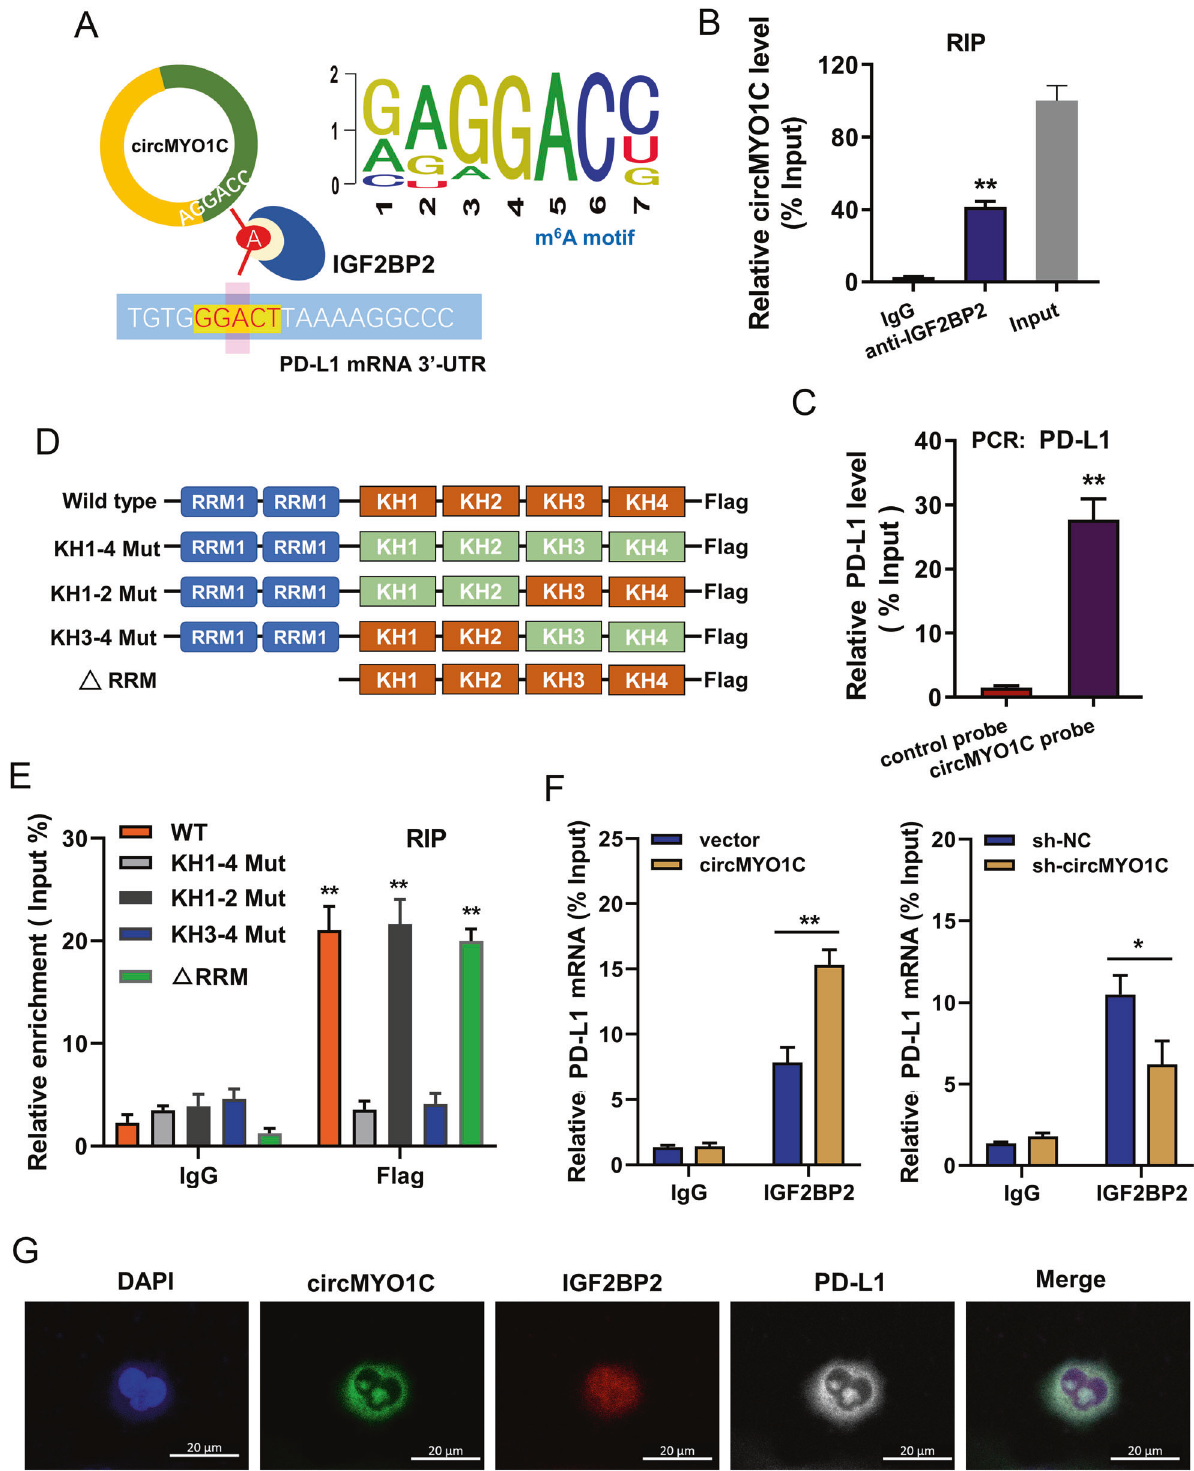
Fig. 5 circMYO1C interacted with PD-L1 through m 6 A reader IGF2BP2. A Schematic diagram indicated the potential m 6 A-modi fi ed sites with both circMYO1C junction sites and PD-L1 3 ’ -UTR. IGF2BP2 motif was GAGGAC (up). B RNA binding protein immunoprecipitation (RIP) analysis detected the circMYO1C expression enriched by anti-IGF2BP2 antibody or control IgG precipitation. C RNA pull-down assay following PCR detected the PD-L1 mRNA level pulled by the circMYO1C probe. D FLAG-tagged full-length and truncated IGF2BP2 mutants were constructed, including 2 RNA-recognition-motif (RRM) domains and 4 K homology (KH) domains. Mutation of GxxG to GEEG was constructed in the KH domains. E RIP-qPCR analysis revealed the relative enrichment of circMYO1C with truncated IGF2BP2 protein complex compared to the input control. ( F ) RIP-qPCR analysis revealed the interaction of IGF2BP2 with PD-L1 mRNA upon circMYO1C overexpression (circMYO1C) or knockdown (sh-circMYO1C). G RNA-FISH showed the colocalization of circMYO1C, IGF2BP2, and PD-L1 in Capan-2 cells. DAPI presents the nucleus. * p < 0.05 and ** p <